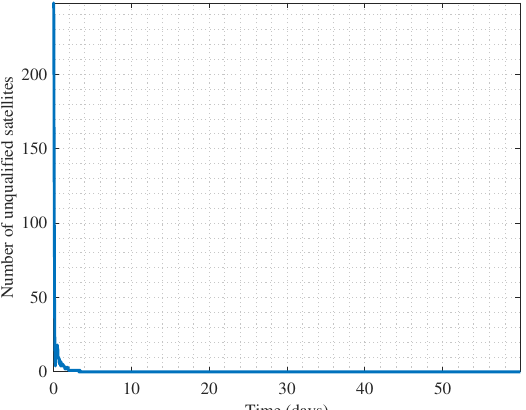
Figure 21. Number of unqualified satellites in the mega constellation.